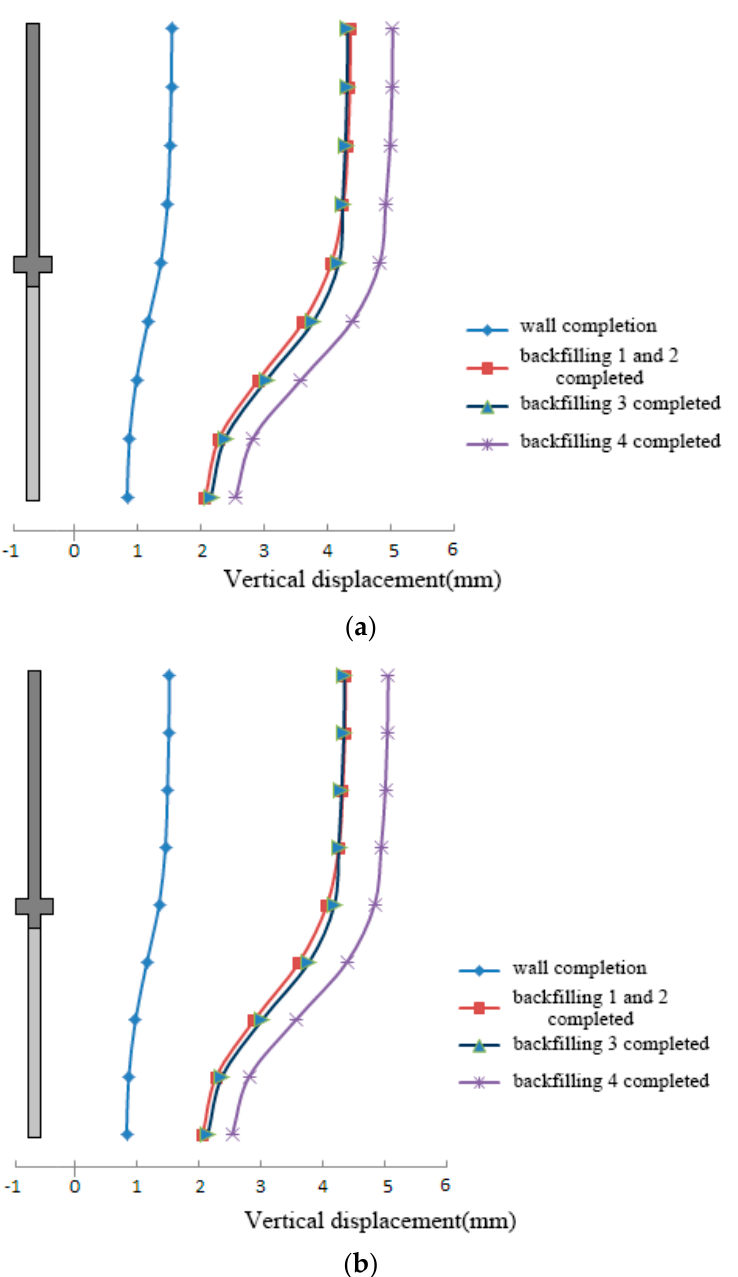
Figure 12. Vertical displacement variation of cut-off wall. ( a ) Monitoring 1 section cut-off wall. ( b ) Monitoring section 2 cut-off wall.